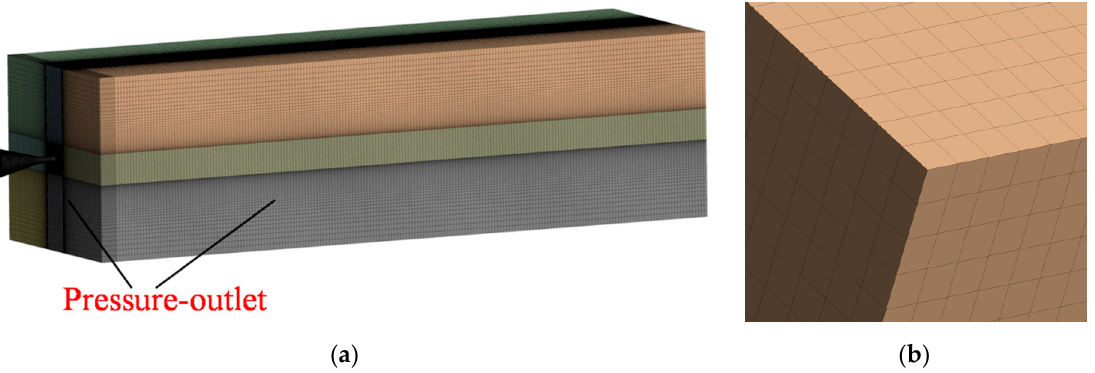
Figure 3. Simulation Model of the nozzle: ( a ) unstructured grid of the nozzle; ( b ) detail view of unstructured grid.